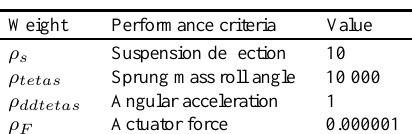
Weight Performance criteria Value ρ s Suspension